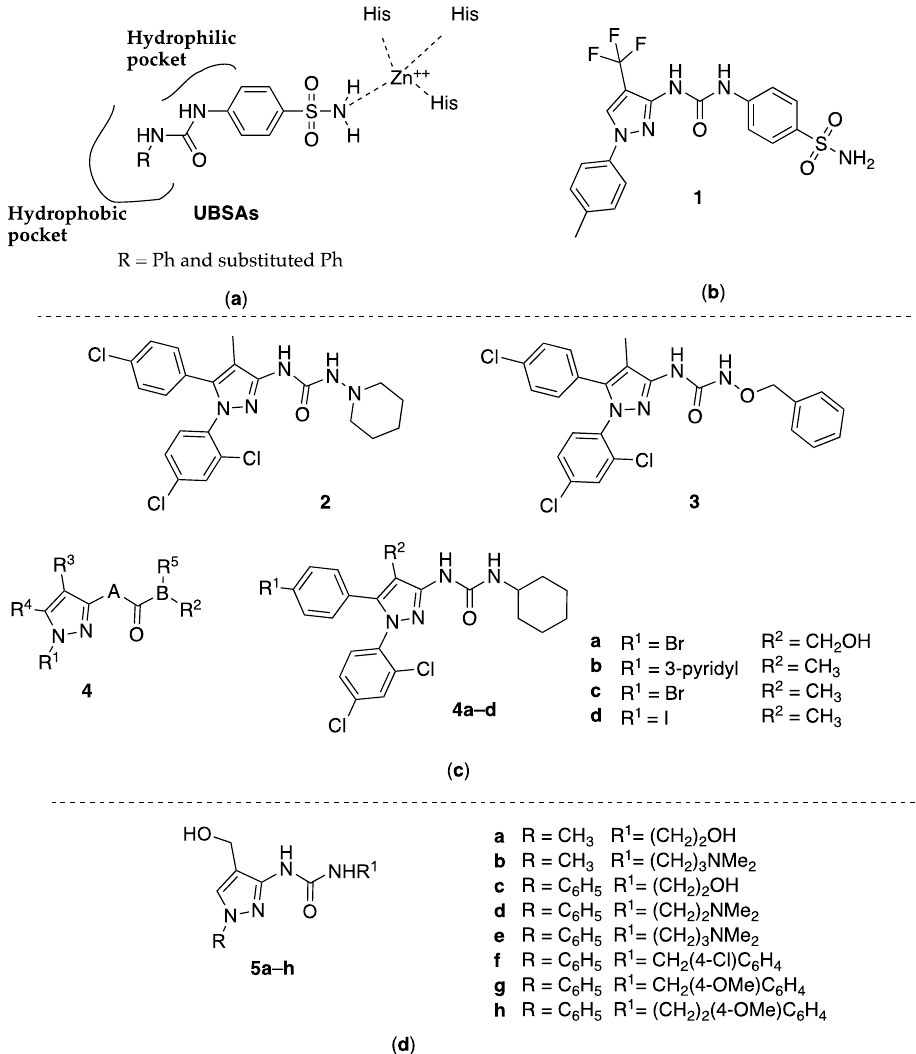
Figure 1. ( a ) General structure of UBSAs and their localization in the binding pocket of hCA (adapted from Sahu, 2013 [10]). 3-pyrazolyl-urea reported as: ( b ) hCA inhibitors; ( c ) CB1/CB2 receptor antagonists; ( d ) antibacterial/antifungal agents.